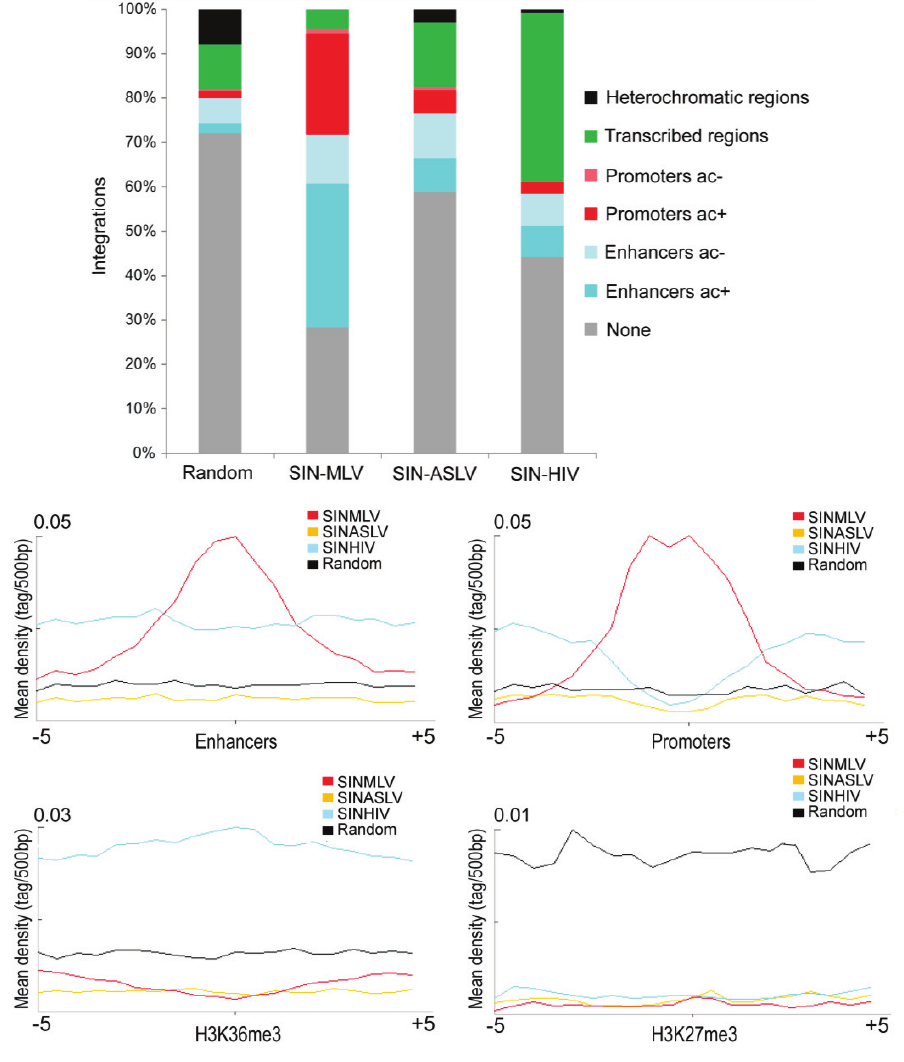
Figure 2. Association of vector integration sites with different epigenetically-defined chromatin states. ( a ) The percentage of integration sites associated with specific, epigenetically defined genomic regions for each vector type. Chromatin states are categorized on the basis of the combination of different epigenetic marks mapped by ChIP-seq in human HSPCs. Only integration sites that are unambiguously associated with one chromatin state were used for the analysis. ( b ) The mean densities of H3K4me1, H3K4me3, H3K36me3 and H3K27me3 ChIP-seq fragments in a 5-kb window around all SIN-MLV (red), SIN-ASLV (yellow) and SIN-HIV (light blue) integration sites and random sequences (black). ac: